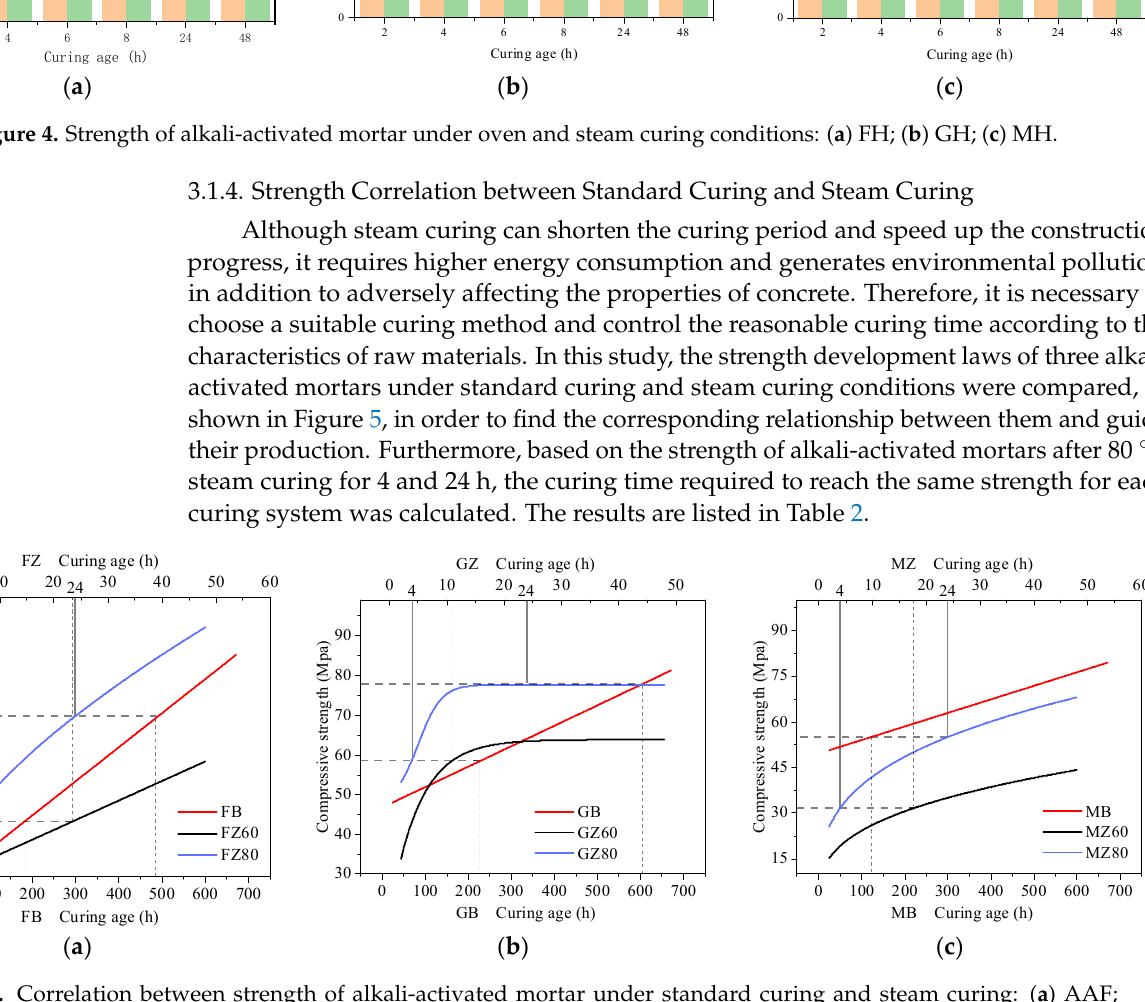
Figure 5. Correlation between strength of alkali-activated mortar under standard curing and steam curing: ( a ) AAF; ( b ) AAG; ( c ) AAM.